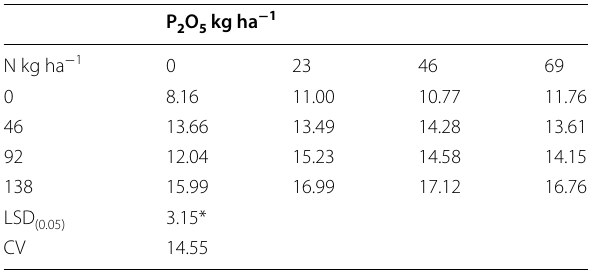
* and ** significant and highly significant respectively Table 7 Combined analysis of potato marketable yield t ha − 1 at